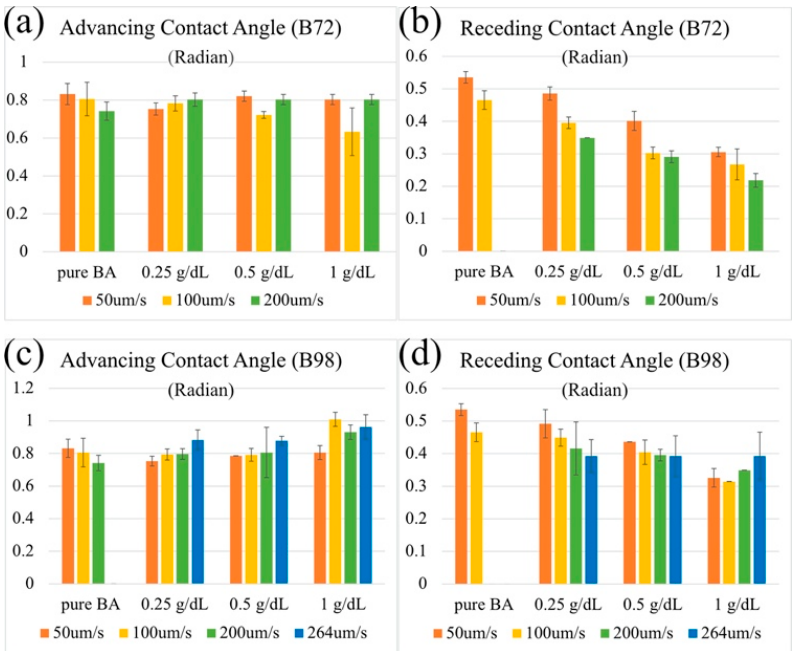
Figure 7. The resulting advancing ( a , c ) and receding ( b , d ) dynamic contact angles of PVB solutions at different concentrations, velocities, and molecular weights of PVB.